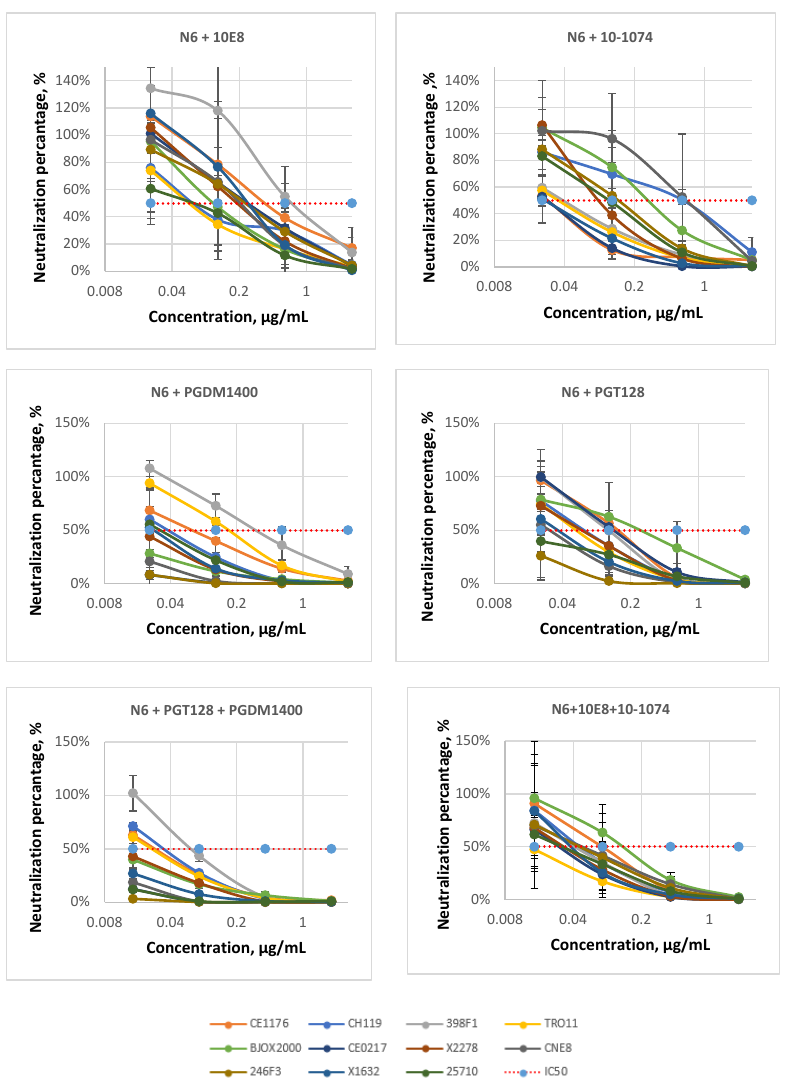
Figure 4. Pseudoviruses neutralization curves for bNAbs combinations (n = 2, ± SEM, on the Y-scale, 100% means no neutralization and 0%—complete neutralization).